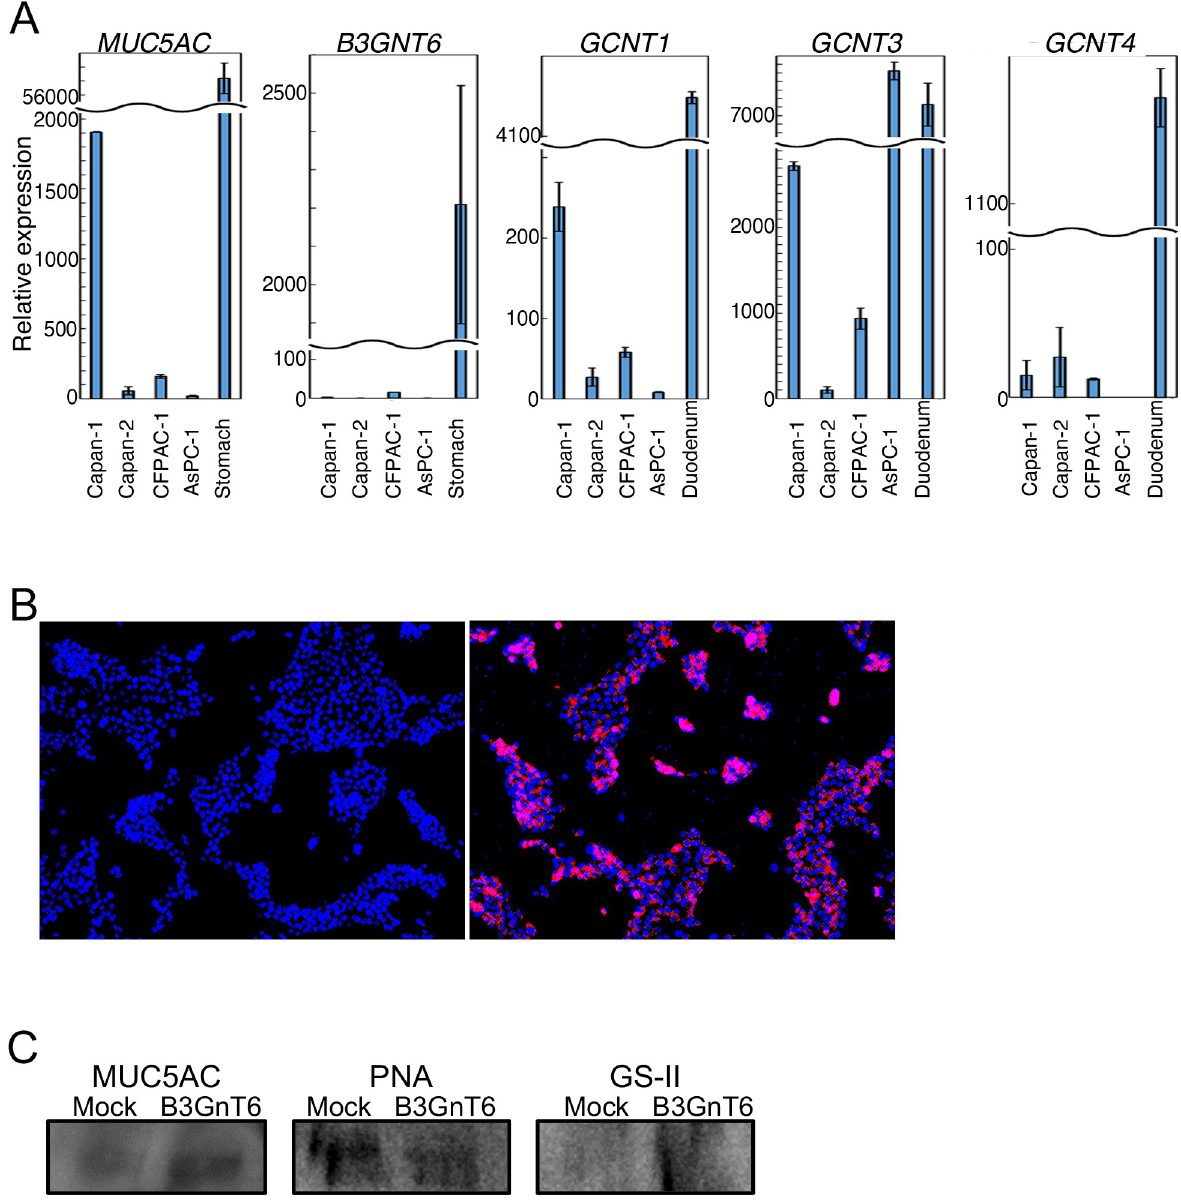
Fig 5. MUC5AC has core 3 O -glycan generated by B3GNT6 gene expression in pancreatic cancer cells. (A) Comparison of expression of genes MUC5AC , B3GNT6 , and core 2 O -glycan synthase among PDAC cells. Capan-1 cells express MUC5AC more highly than the other cell lines but do not express B3GNT6 . (B) Capan1-B3GnT6 cells (right panel) but not Capan1-mock cells (left panel) express β 3Gn-T6 as detected by the immunofluorescence assay (red). Nuclei are stained by 4’,6-diamindino-2-phenylindole (DAPI, blue). (C) MUC5AC immunoprecipitated with the anti-MUC5AC antibody was subjected to SDS-PAGE and transferred to a nitrocellulose membrane, then the membrane was blotted with GS-II, PNA, or the anti-MUC5AC antibody. The level of nonreducing terminal GlcNAc is higher in Capan1-B3GnT6 cells compared to Capan1-mock cells, even though the MUC5AC amount is comparable between these two cell lines. Conversely, the T antigen level is lower in Capan1-B3GnT6 cells compared to Capan1-mock